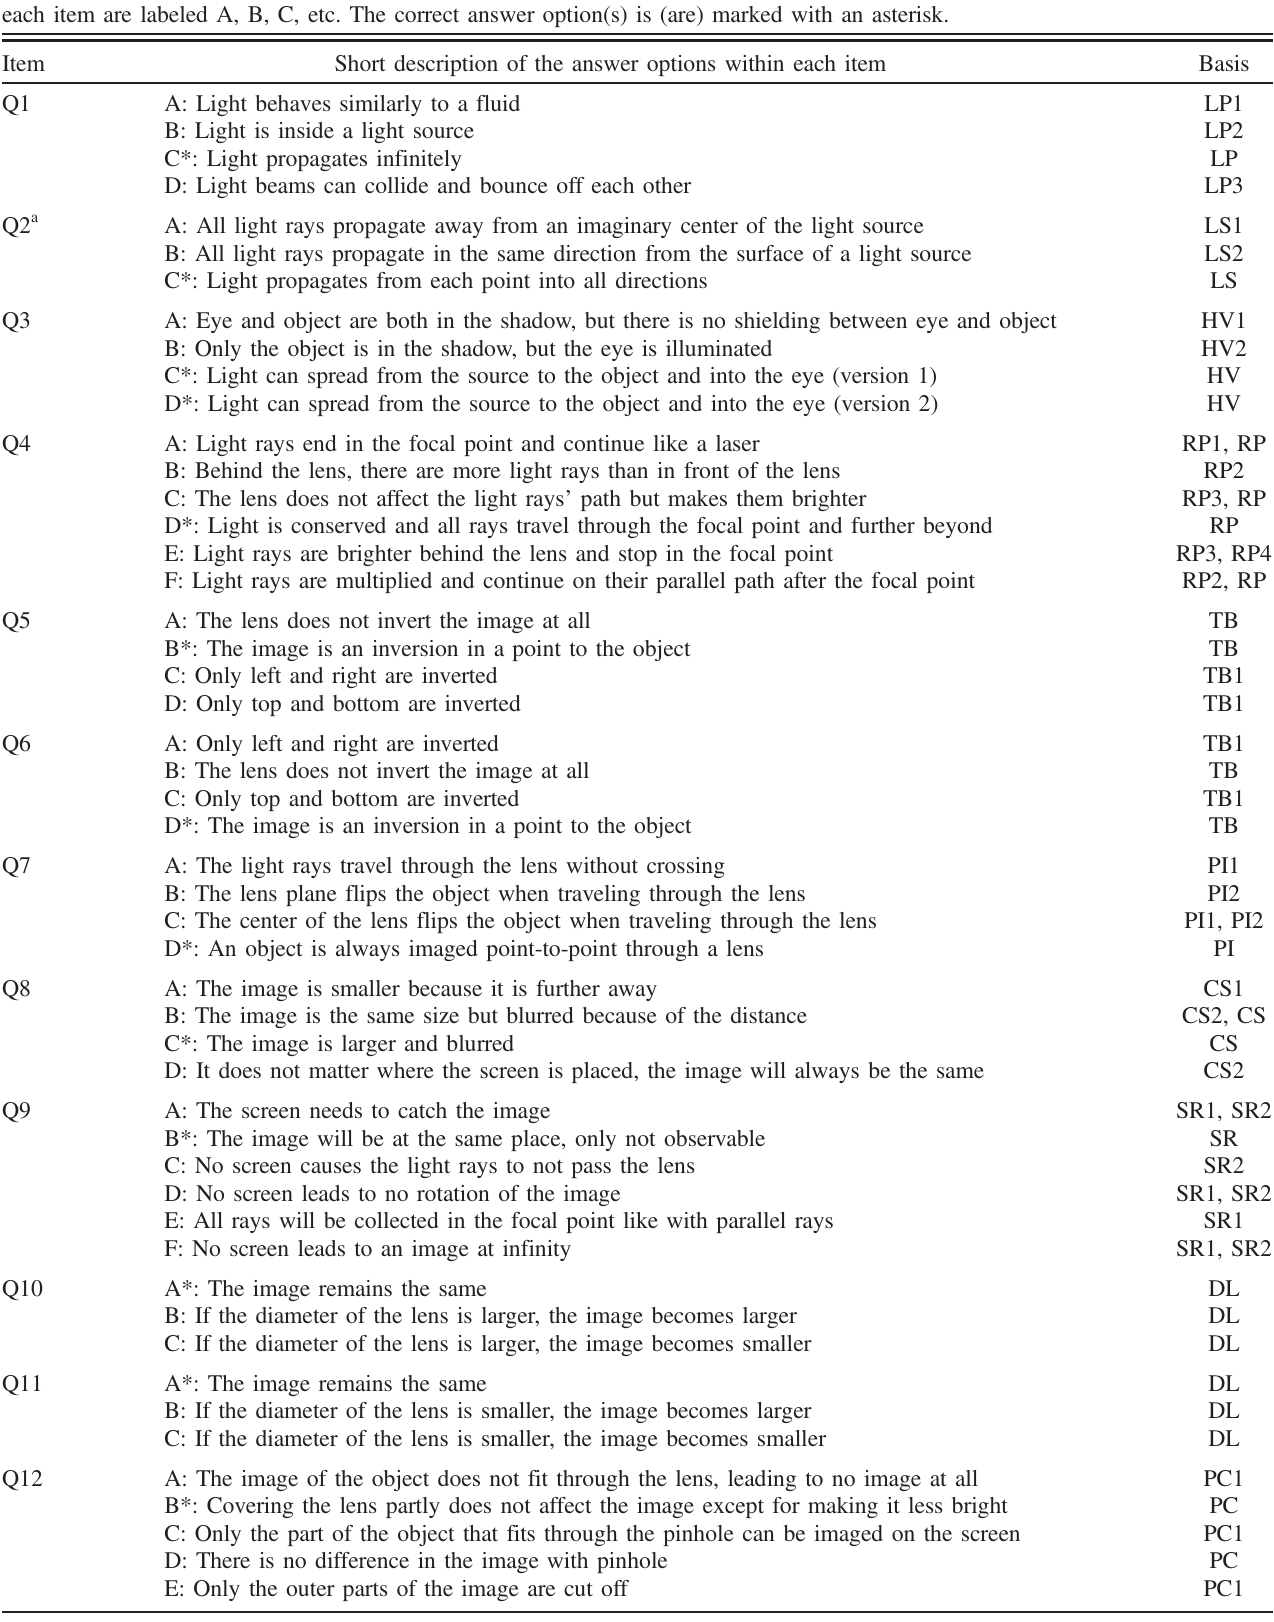
TABLE II. Description of the single items and the core concepts and student difficulties they are based on ( “ basis ” ). Answer options of each item are labeled A, B, C, etc. The correct answer option(s) is (are) marked with an asterisk. Item Short description of the answer options within each item